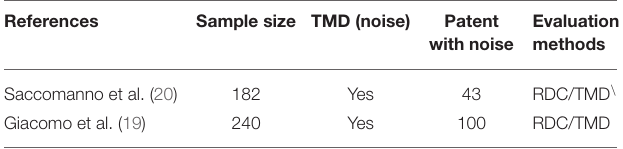
TABLE 3 | Evaluation of TMD (noise) frequency in